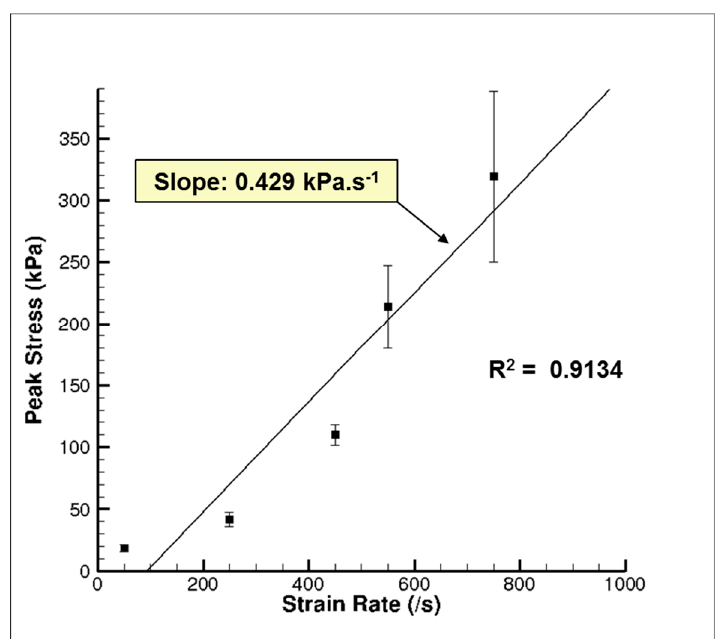
Figure 8. Plot of the initial hardening peak stress, σ p , of the wet porcine brain from the high strain rate tests ranging from 50–750 s − 1 [29]. The water content in the porcine brain was ~80% m/m. Twenty-six brain samples were analyzed. The error bars represent standard error.